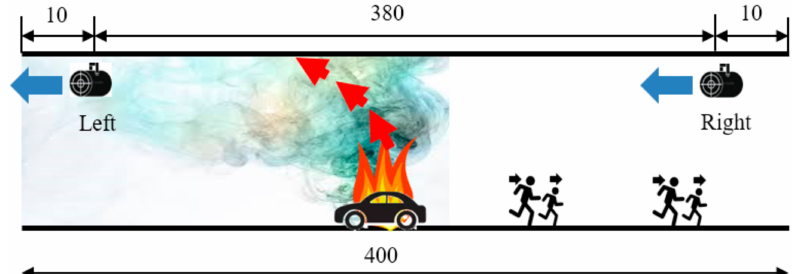
Figure 1. Numerical analysis